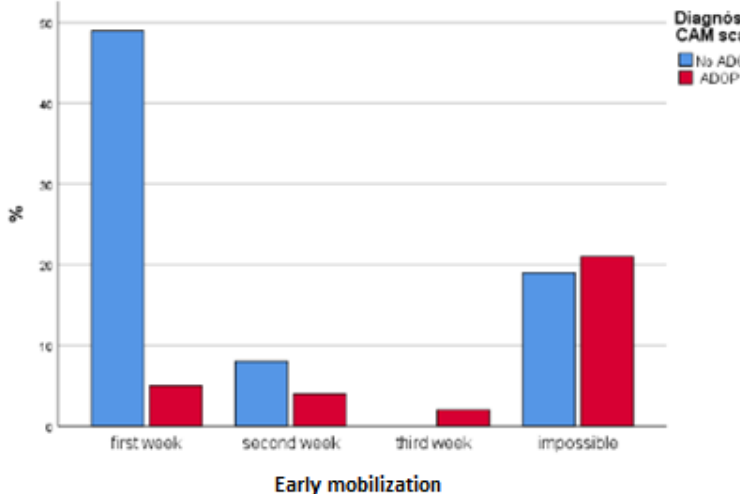
Figure 2. Length of admission.